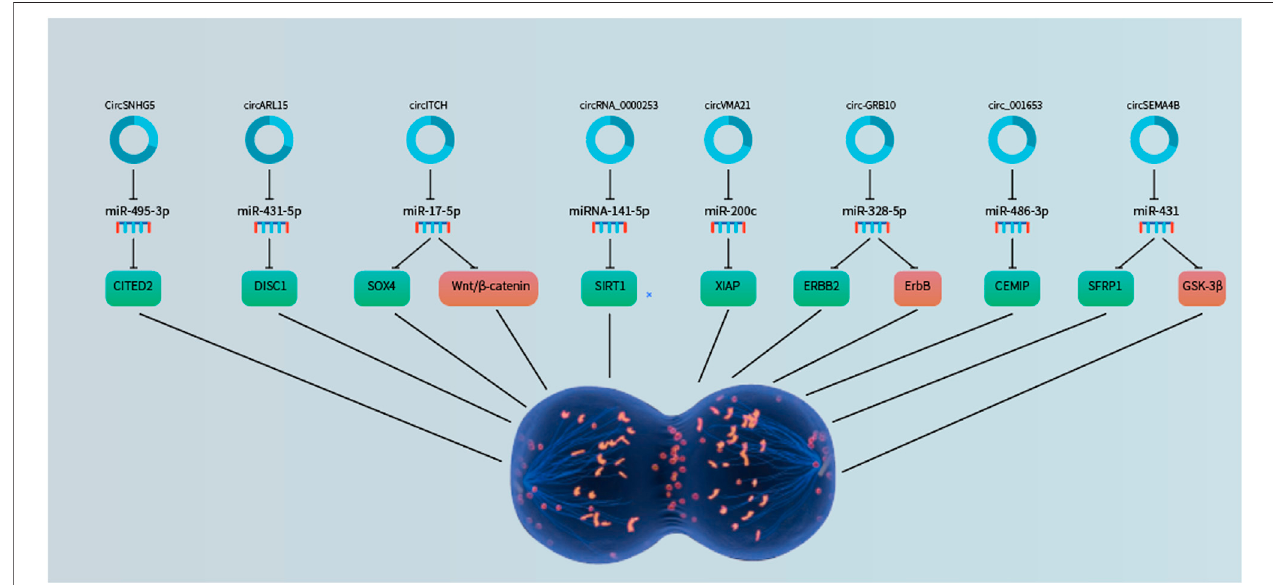
FIGURE 2 | CircRNAs as regulators of NP cell proliferation through sponging microRNAs to derepress the downstream target genes.